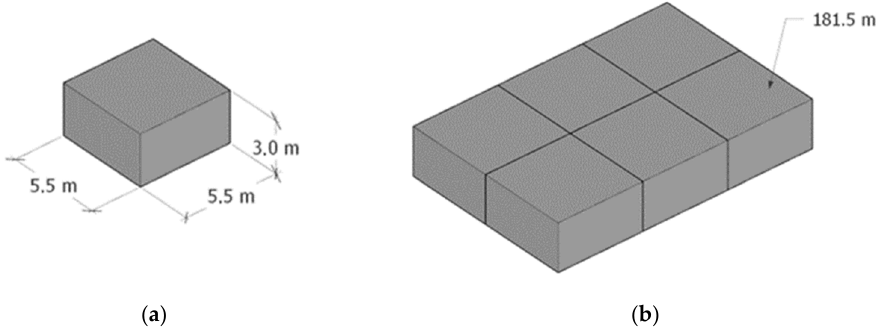
Figure 2. Basic space unit ( a ) and the combination of 6 units ( b ) to assemble a complete family house.